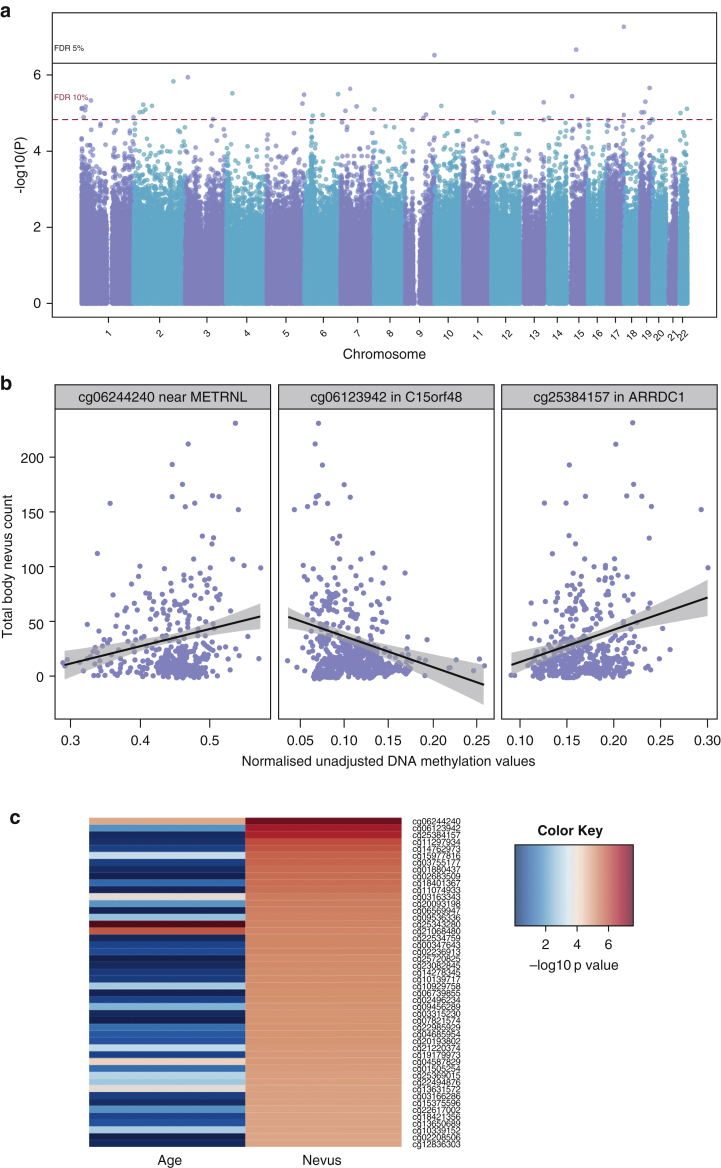
Nevus count epigenome-wide results in 322 female individuals. (a) Manhattan plot of the epigenome-wide association results in 322 female individuals, where each point represents the observed –log10P-value at a CpG site. (b) Panel plot depicting the direction of association at the three top-ranked signals for cg06244240 (left), cg06123942 (middle), and cg25384157 (right). Results are plotted using normalized unadjusted beta values per individual. The lines represent the linear correlation between DNA methylation and total body nevus count. (c) Heatmap of top 48 ranked n-DMPs colored by –log10 P-values of age association and nevus association. DMP, differentially methylated position.